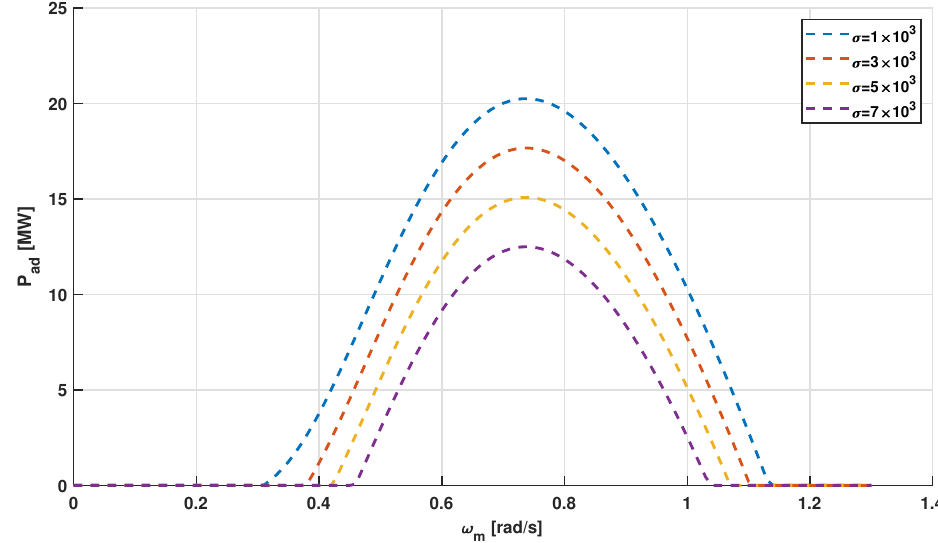
Figure 14. Analytical results of P ad − ω m corresponding to raindrop diameter d = 3 mm and different raindrop densities σ .